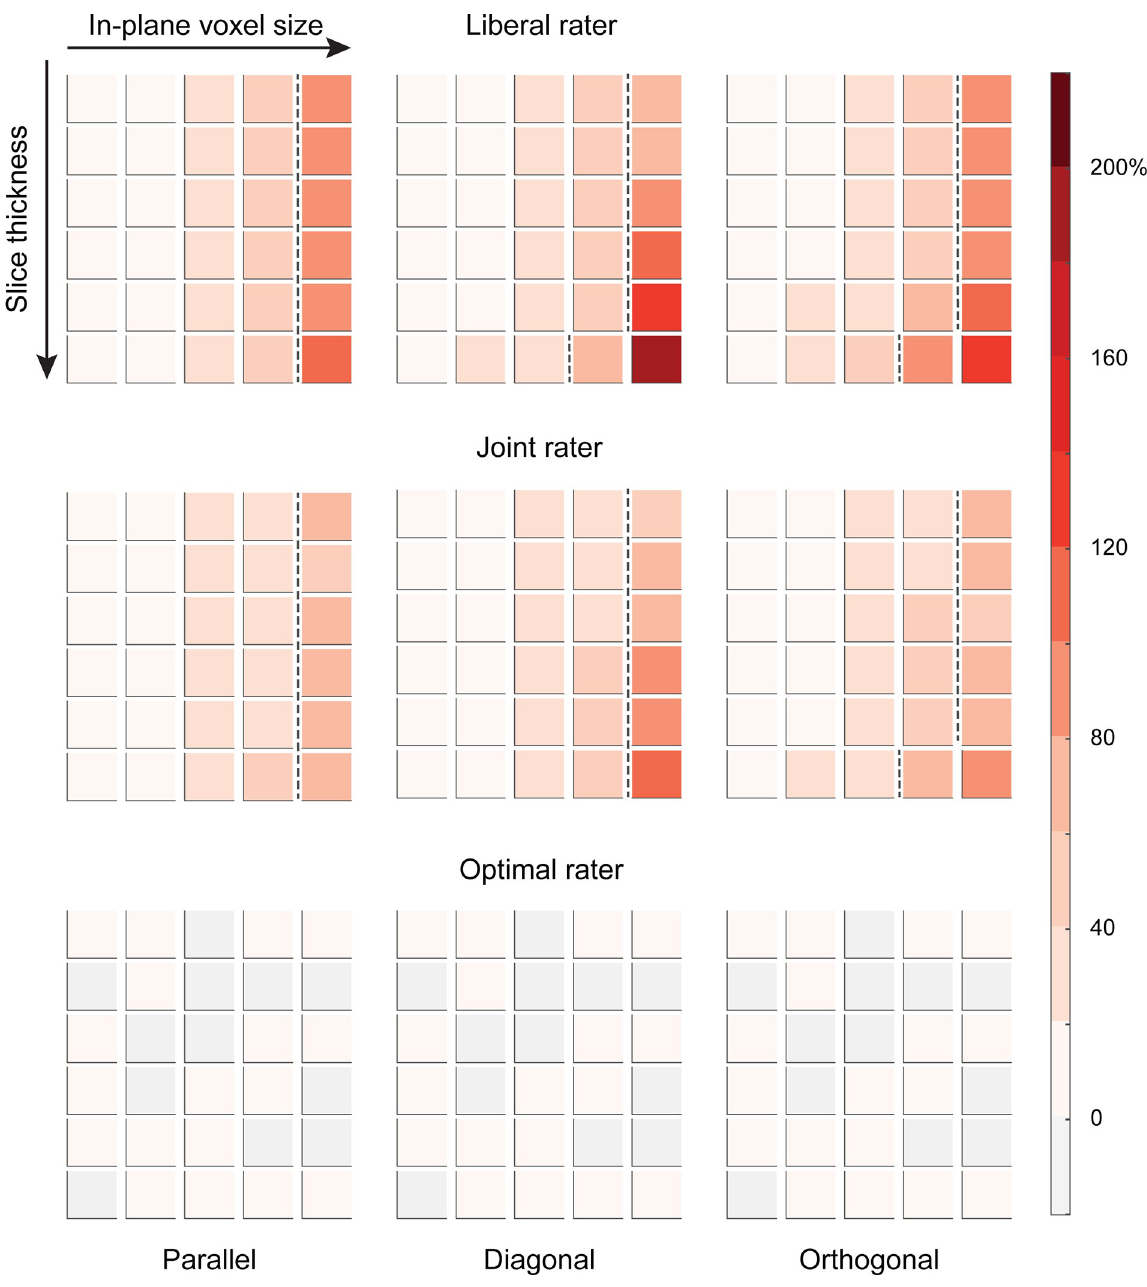
Fig 4. Overview of the average percentage deviation in volume for the simulated ellipsoids (n = 100), labeled according to a liberal, a joint, and an optimal rater. Columns refer to the orientation of the ellipsoid (parallel, diagonal, and orthogonal to the slice axes). Each block of squares represents sizes and shapes as depicted in Fig 2, with increasing in-plane voxel size (0.1 to 2.0mm) from left to the right, and increasing anisotropy (1x to 3x the in-plane voxel size) from top to bottom, with each top row being isotropic. Color intensity indicates the average percentage deviation in volume. Blocks to the right of the dotted lines represent deviations in volume that are > 57% of the ground truth, corresponding in DSC scores < 0.75, as shown in Fig 5 below (see S1 Fig for the relationship between volume deviations and